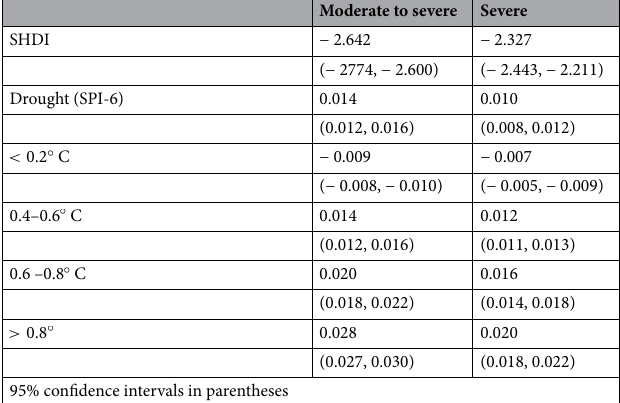
Table 3. Regressions with bins of monthly temperature anomalies (0.2–0.4 ◦ C is the reference bin).